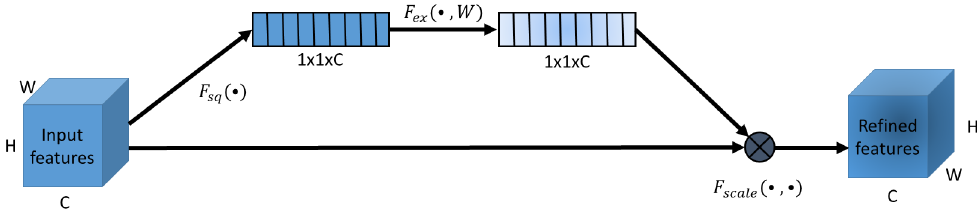
Figure 2. Squeeze and excitation module. The module first squeezes the input features to a vector with the shape 1xC (C: number of channels in the input features). This is followed by the excitation operation where a multi-layer perceptron processes the input vector. The final output feature map is calculated by multiplication between the output vector and the input feature map. Adapted with permission from Ref. [22]. 2018,